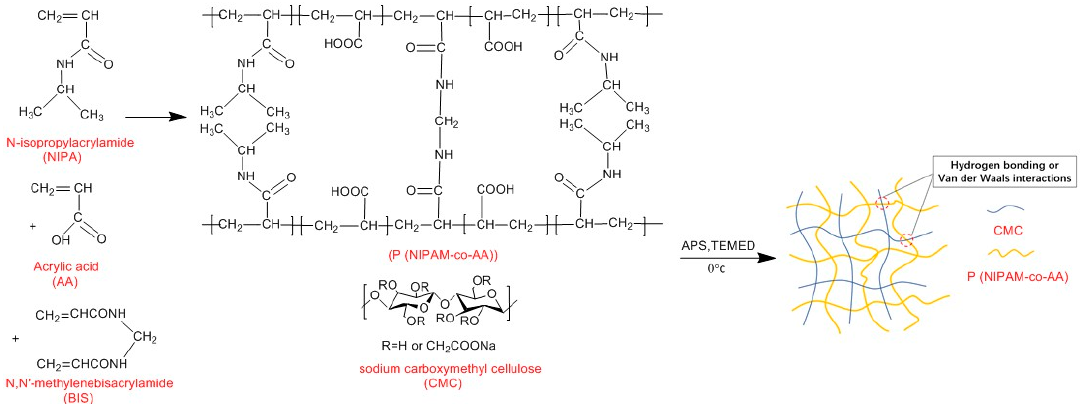
Figure 1. Proposed fabrication process of the CMC/P (NIPAM-co-AA) hydrogel.